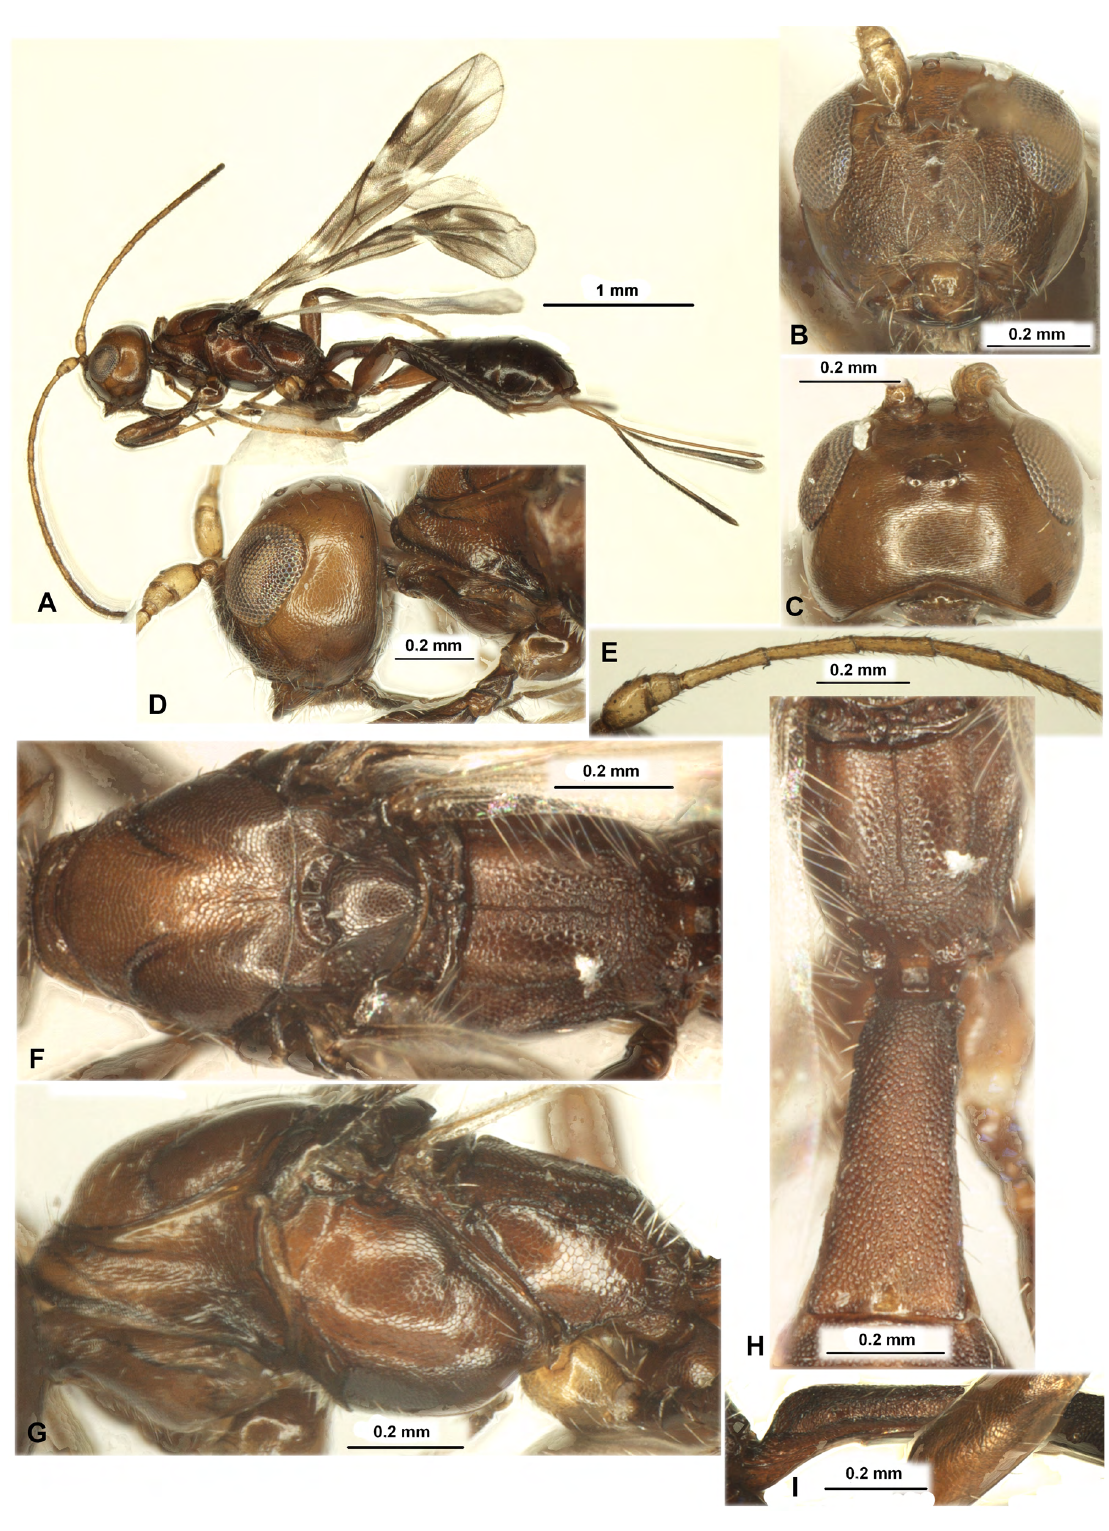
Fig. 32. Platyspathius ( Platyspathius ) ornatulus Enderlein, 1912, ♀, lectotype, MIZW. A . Habitus, lateral view. B . Head, lateral view. C . Head, front view. D . Head, dorsal view. E . Apical segments of antenna. F . Basal segments of antenna. G . Mesosoma, lateral view. H . Mesosoma, dorsal view. I . Hind femur and tibia, lateral view. J . First metasomal tergite, lateral